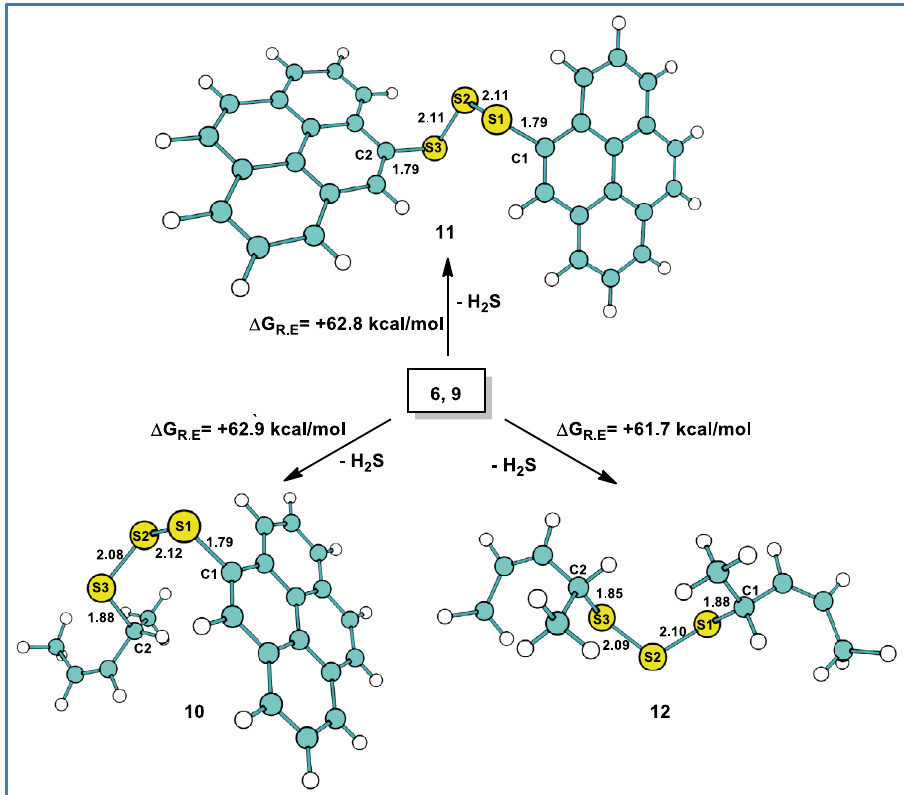
Figure 9. Optimized crosslinked reaction product geometries from sulfurated pyrene and/or 2-pentene, 10 , 11 and 12 , respectively. Optimized bond lengths are shown in Å.